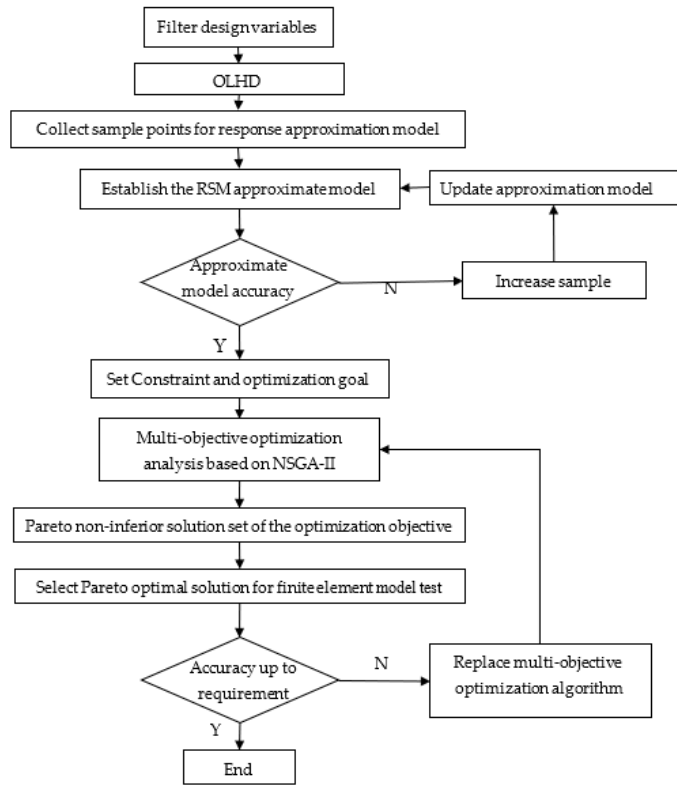
Figure 9. Multi-objective optimization of the thickness in B-pillar based on the response surface Figure 9. Multi ‐ objective optimization of the thickness in B ‐ pillar based on the response surface methodology (RSM) and the non-dominated sorting genetic algorithm methodology (RSM) and the non ‐ dominated sorting genetic algorithm (NSGA ‐ II).